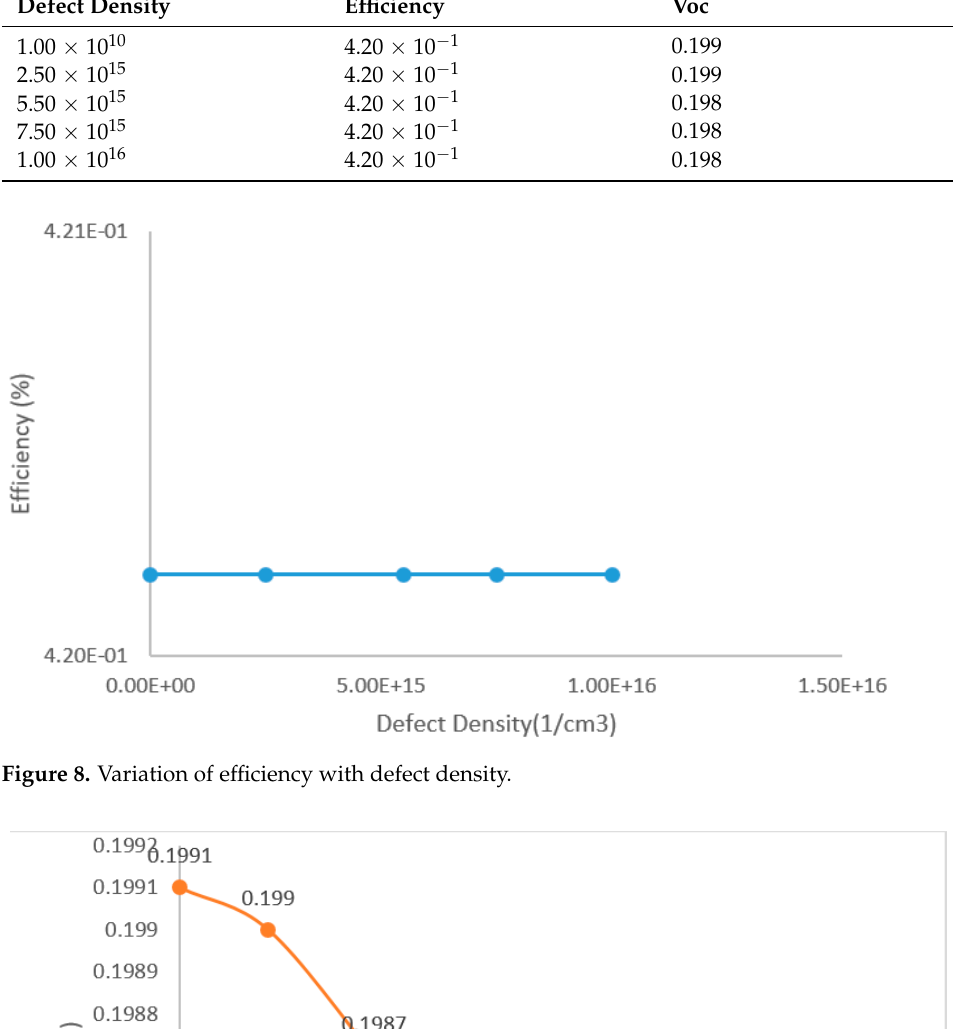
Figure 10. Energy-level diagram of structure C60/LMNO/Cu 2 O.